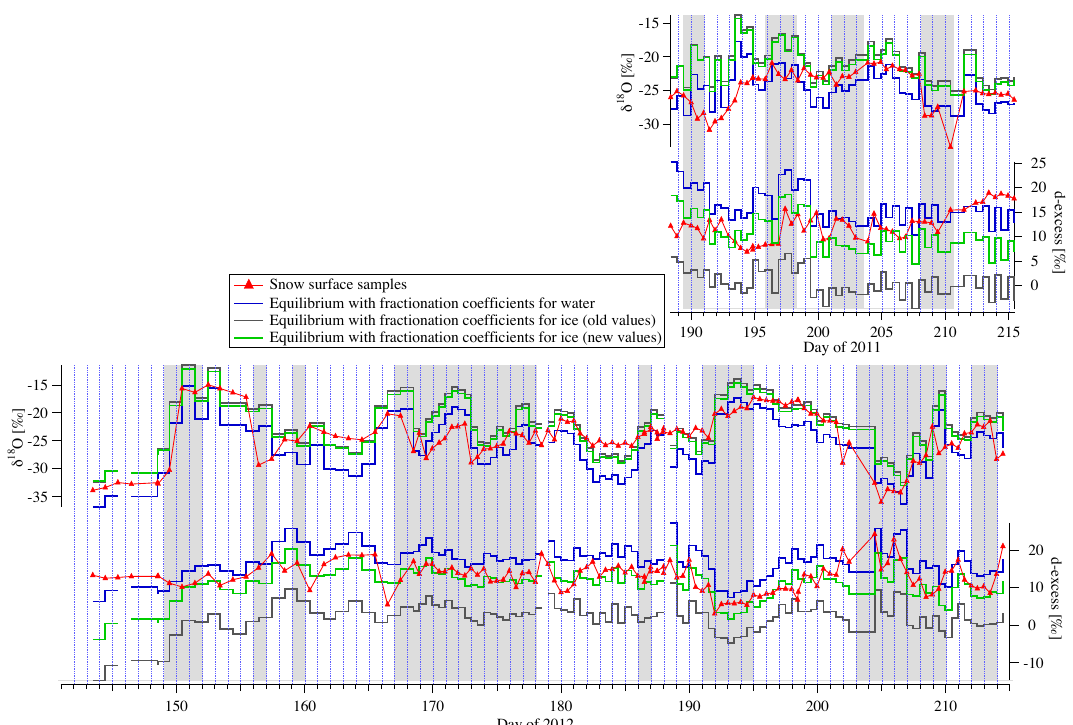
Fig. 4. δ 18 O and d-excess of the condensate calculated based on the air temperature and observed atmospheric water vapor isotopic compo- sition under the assumptions of isotopic equilibrium. Different fractionation coefficients were used assuming liquid water (Majoube, 1971), ice (Majoube, 1970; Merlivat and Nief, 1967), and ice but with new fractionation coefficients estimated by Ellehoj et al.